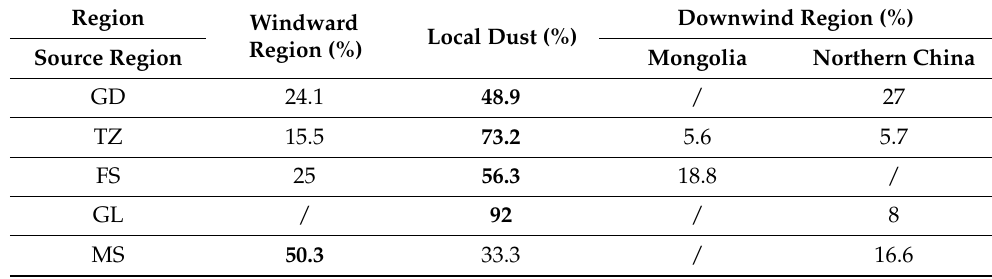
Table A1. Mongolian DSN statistical result.